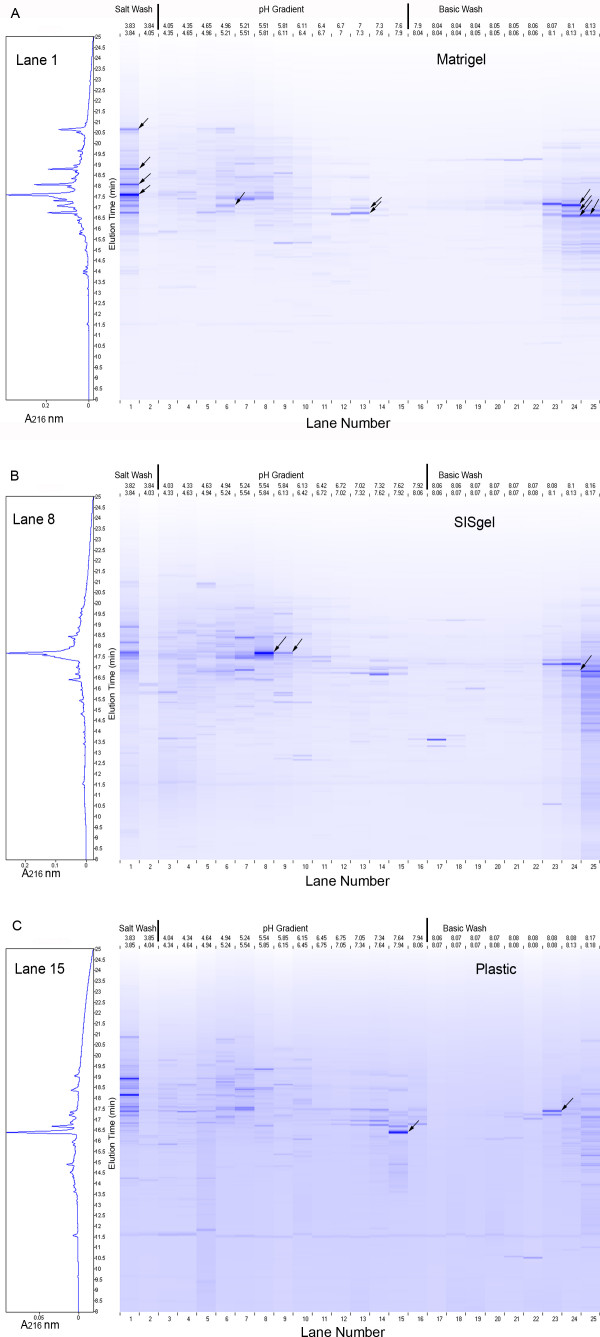
"Gel-view" proteomic display of J82 cells cultured on Matrigel (A), SISgel (B) and plastic (C). Due to the current software configuration, the elution is from right to left, with lanes 17–25 showing proteins eluted during the base wash, lanes 2–16 showing proteins eluting during the pH 8.3-4.0 gradient, and lane 1 showing proteins eluting in the 1.0 M NaCl wash. The Y axis shows the retention times of the second dimension between 10 and 24 minutes. The software presents the elution pattern as a simulated gel-view in which the color intensity is proportional to the absorbance. On the left of each display is shown a chromatographic view of one lane from which fractions were obtained for MS analysis presented as A216 vs retention time. The black arrows identify fractions taken for MS analysis and reported in Table 1.